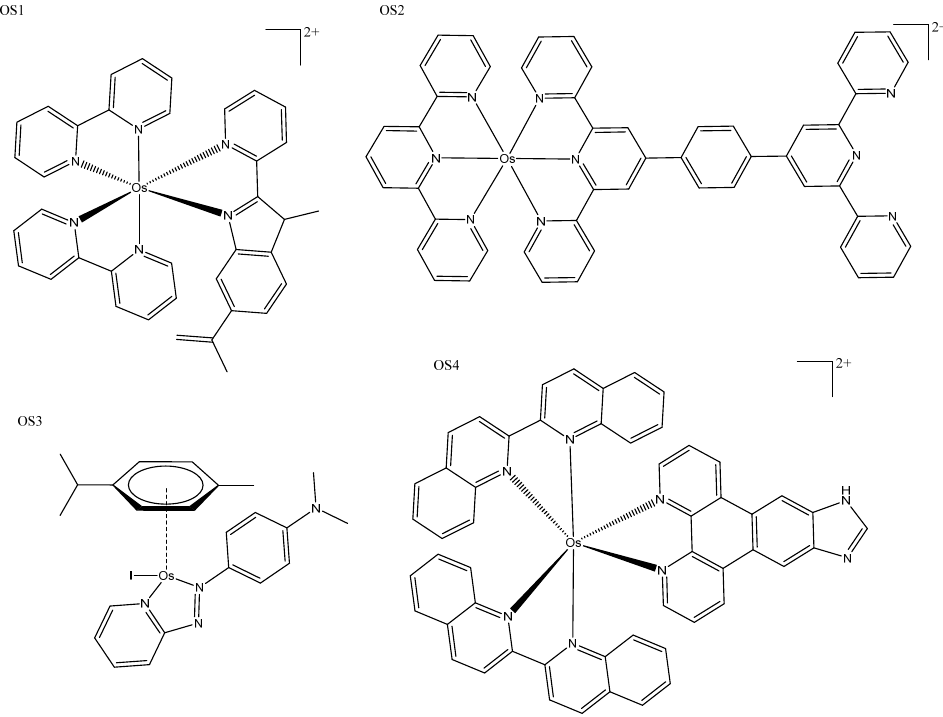
Figure 13. Osmium complex OS1 [104], tridentate terpyridine complex OS2 [105],